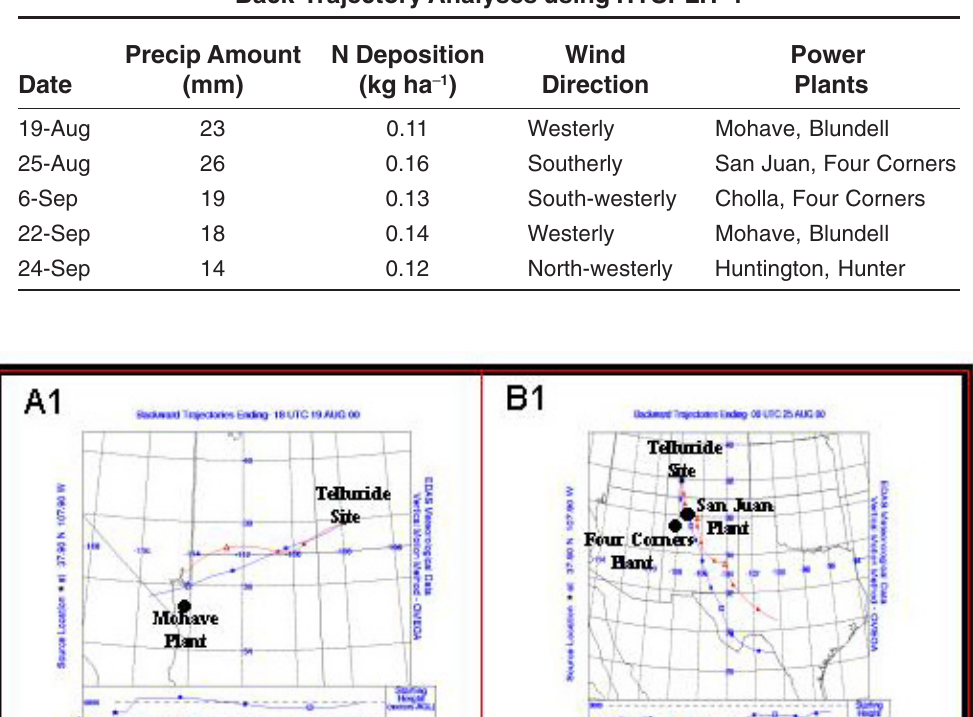
Trajectory Analysis